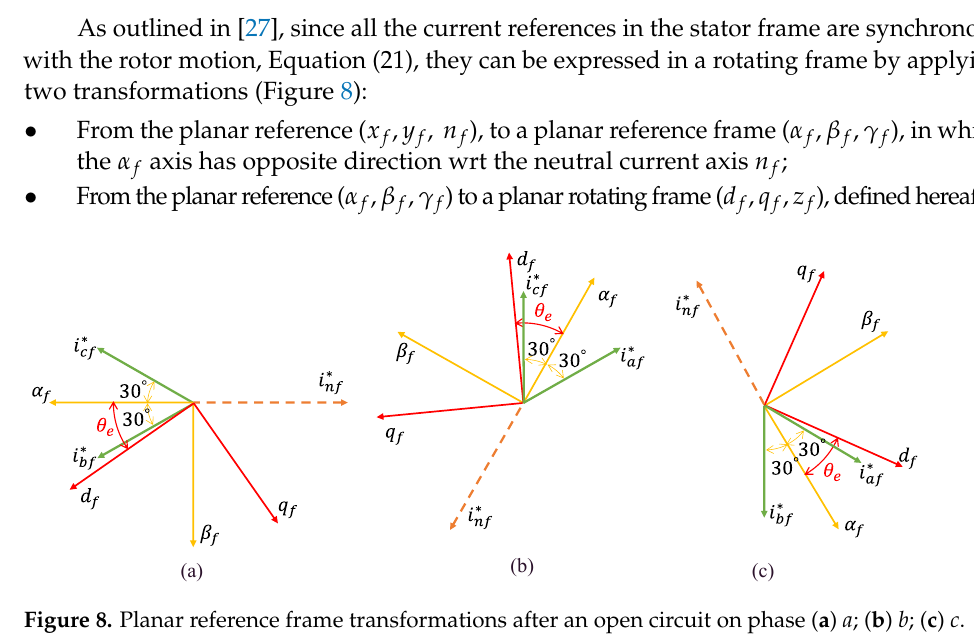
Figure 7. Post-fault current references: fault on ( a ) phase a ; ( b ) phase b ; ( c ) phase c .